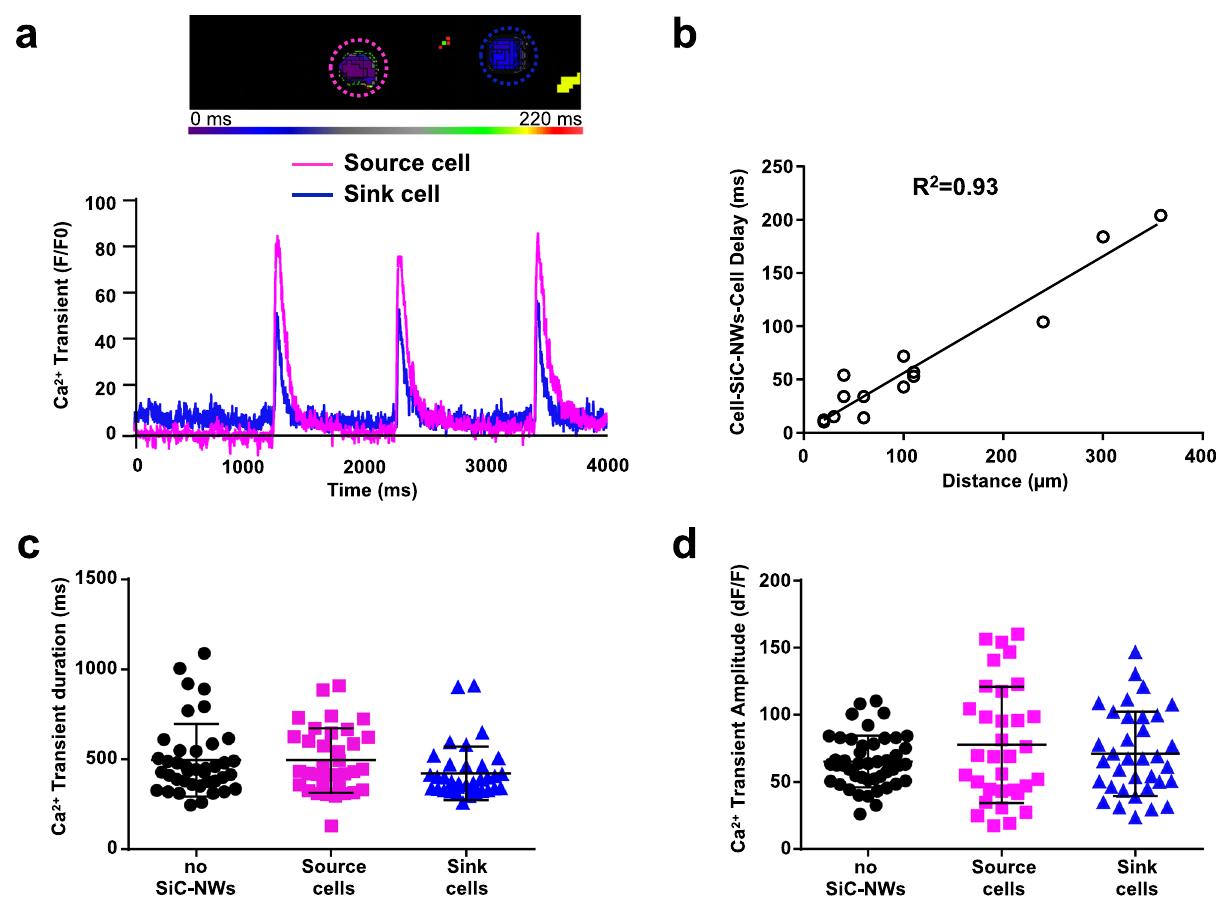
Fig. 5 Synchronization of electrotonic intracellular Ca 2 + transients over distance in synthetic cell – cell coupling. a Top. Color-coded time course of Ca 2 + initiation in two MNB-connected HL1 cells. Pink-dashed circle, source cell; blue-dashed circle, sink cell. Bottom. Relative series of spontaneous intracellular Ca 2 + transient traces from the source (pink) and sink (blue) cell. n = 35 experiments repeated with similar results. b Intracellular Ca 2 + transient delay from coupled cell pairs connected by SiC-NWs over distance, showing a linear correlation ( n = 15). c Intracellular Ca 2 + transient duration in control (no SiC- NWs, n = 48, black dots) source cells ( n = 35, pink squares), and sink cells ( n = 35, blue triangles). d Same as c , but for Ca 2 + amplitude. Data expressed as mean ± SD. Unpaired two-sided Student ’ s t -test (signi fi cance set at p < 0.05). Source data are provided as a Source Data fi